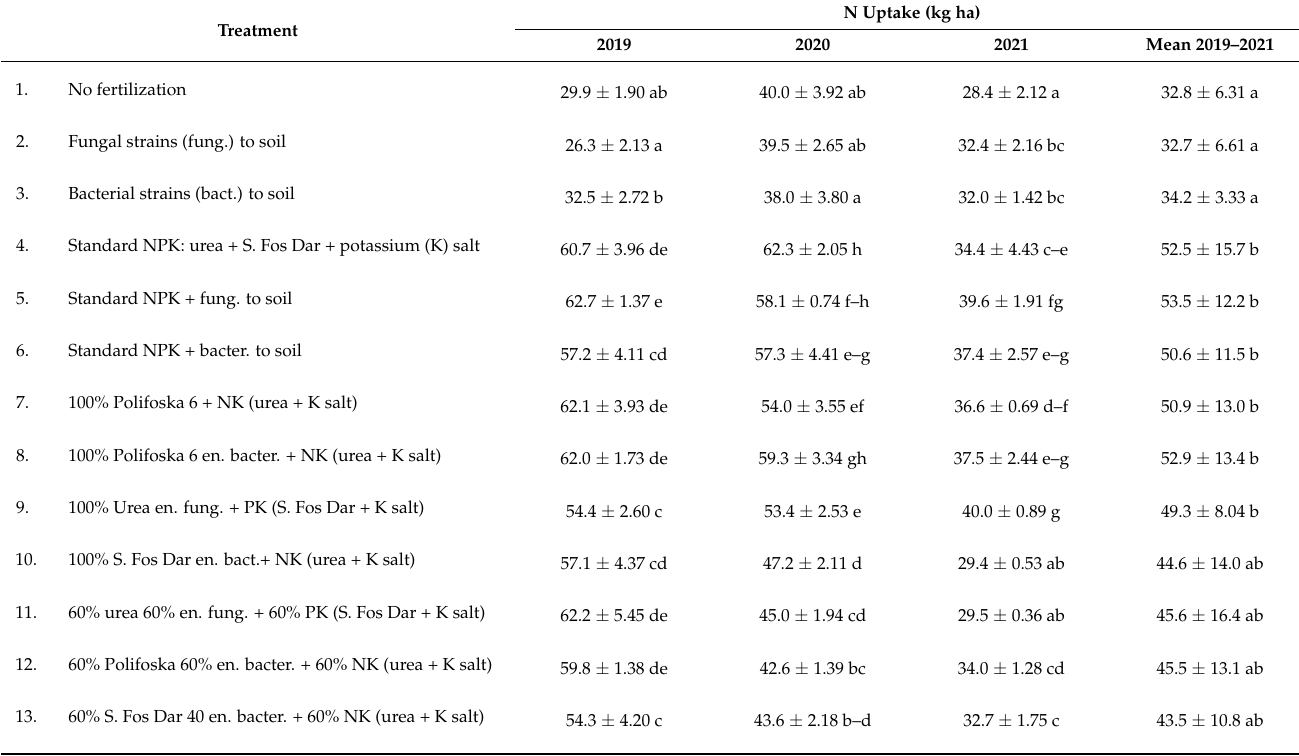
Table 6. N uptake by weed shoots in the apple orchard,